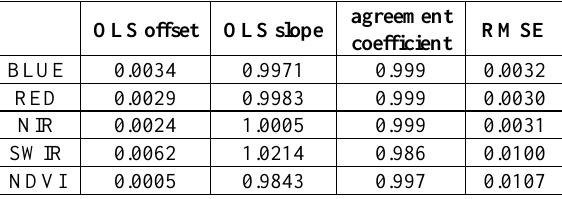
Table 3. TOA spectral correction functions between PROBA-V and VGT2